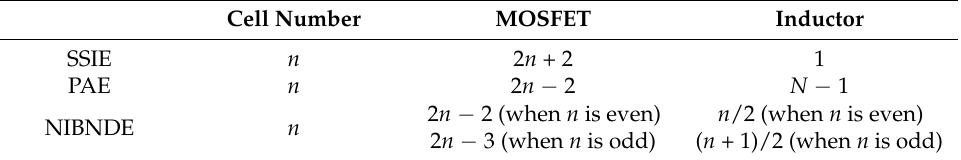
Table 8. The comparison between SSIE, PAE and NIBNDE in an n cell battery string ( n ≥ 2).